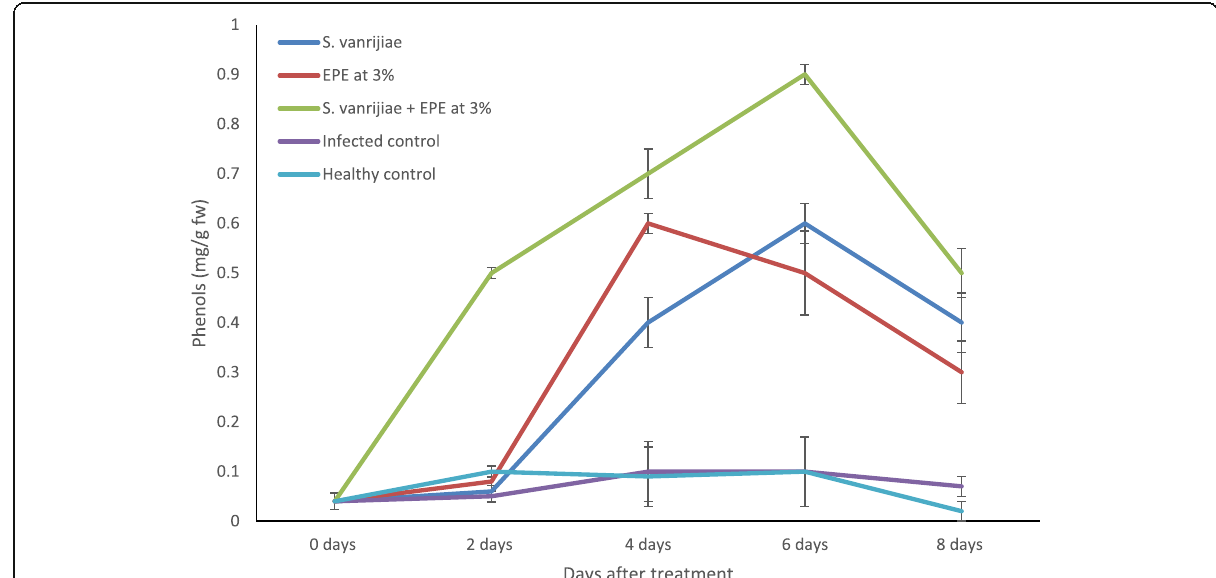
Fig. 5 Time course of phenol content (phenols (mg/g fw) in extracts from lemon cv seedless limes tissues treated or not with S . vanrijiae and 3% EPE in mixture. All the values are the means of four replicates ±